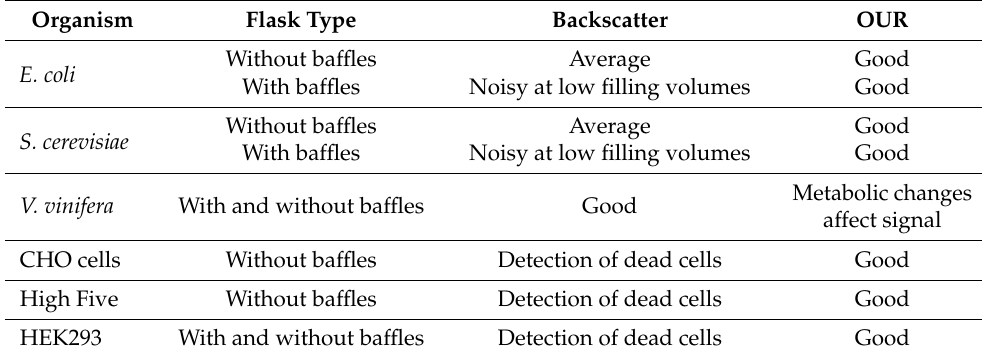
Table 2. Organism-based evaluation of BSL and OUR signal for baffled and unbaffled shake flasks.